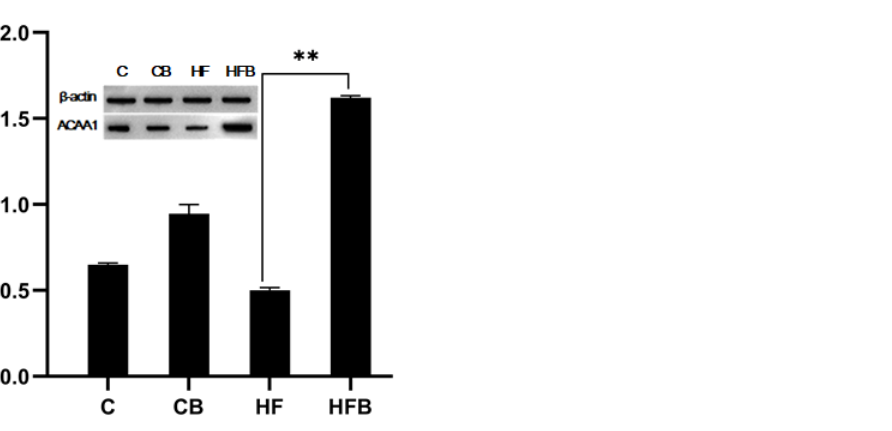
Figure 8. Verification of the expression of liver protein in the different groups. The Western blot bands of ACAA1A. Actin was used as reference. ** p < 0.01.